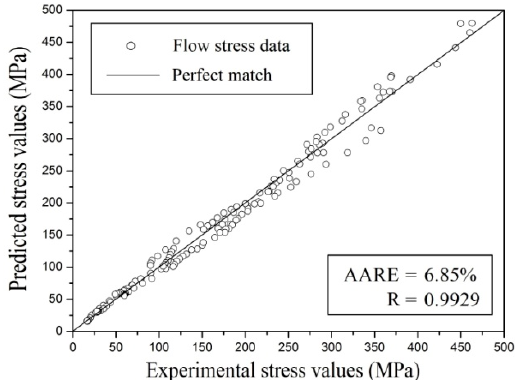
Figure 10. The correlation between predicted data and experimental data over the entire range of strain, strain rate, and temperature.